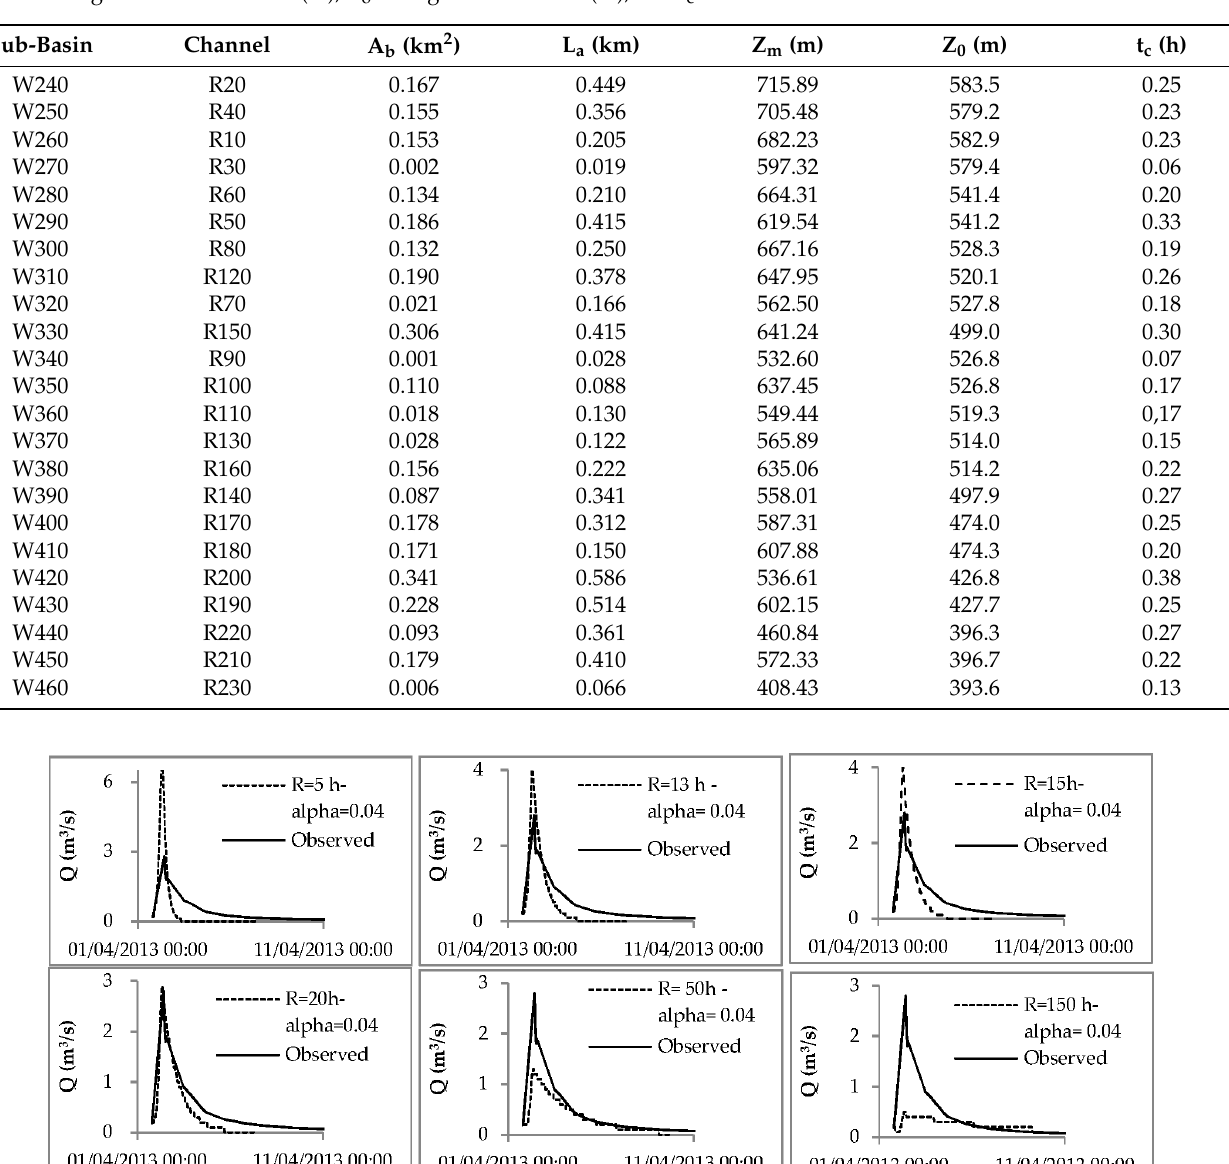
Table 6. Morphometric parameters of Ciciriello’s sub-basins. A b : watershed area; L a : length of the main channel (km); Z m = mean height of the watershed (m); Z o = height at the outlet (m); and t c = the time of concentration of the watershed.